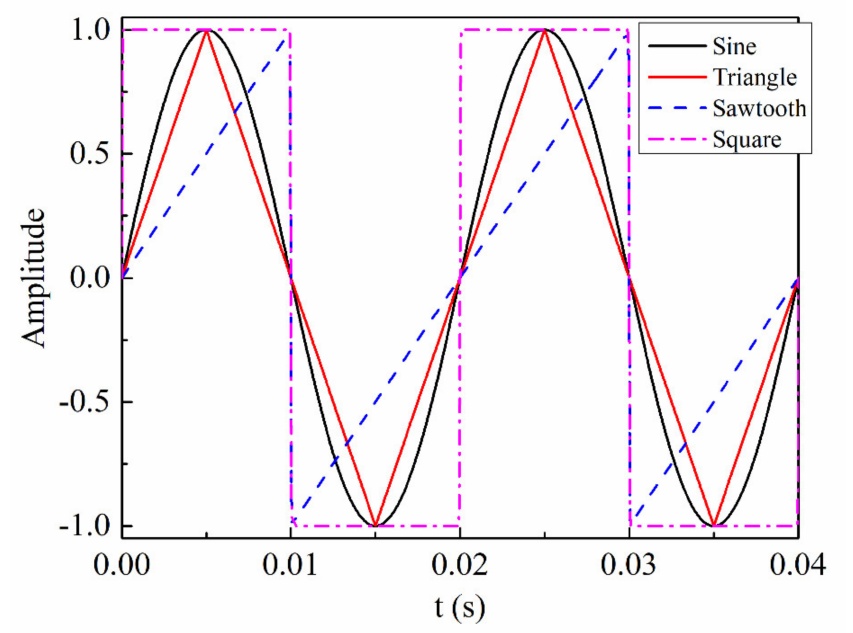
Figure 2. Oscillating external magnetic field waveform over